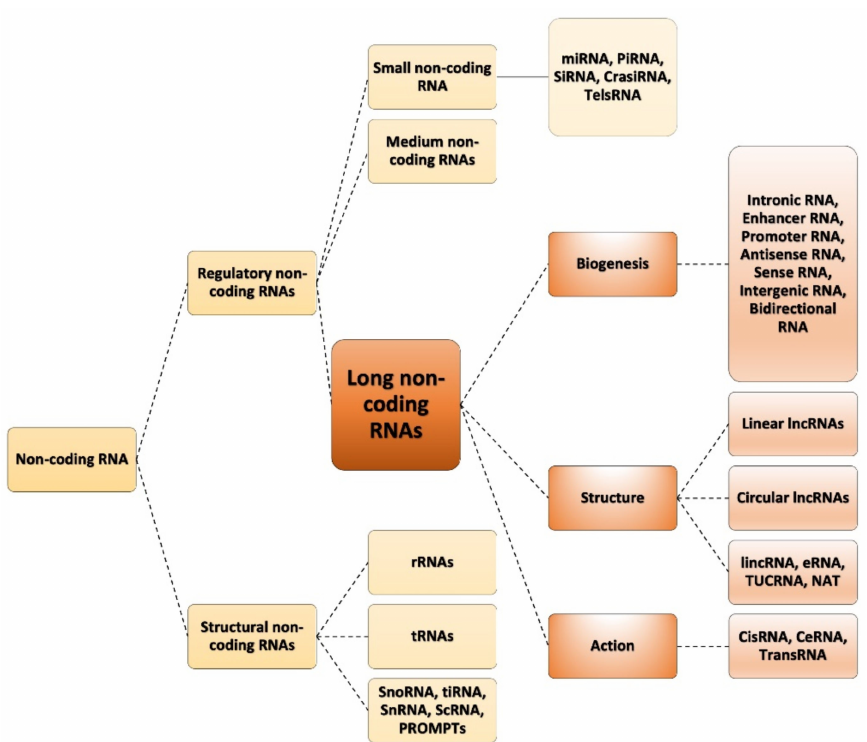
Figure 1. ncRNAs classes: schematic classification of ncRNAs into classes and sub-classes according to their actions, biogenesis and structures (snoRNA: small nucleolar RNAs; tiRNA: transcription initiation RNA; snRNA: small nuclear RNA; scRNA: small cytoplasmic RN; PROMPTs: promoter upstream transcripts; rRNAs: ribosomal RNAs; tRNAs: transfer RNAs; miRNA: micro RNA; piRNA: piwi RNA; siRNA: small interfering RNA; crasiRNA: centromere repeat-associated small inter- acting RNA; telsRNA: telomere-specific small RNA; lincRNA: long intergenic noncoding RNA; eRNA: enhancer-derived RNA; TUCRNA: transcribed ultraconserved RNA; NAT: natural antisense transcript; cis -lncRNA: cis -acting long non-coding RNA; ceRNA: competing endogenous RNA; trans -lncRNA: trans -acting long non-coding